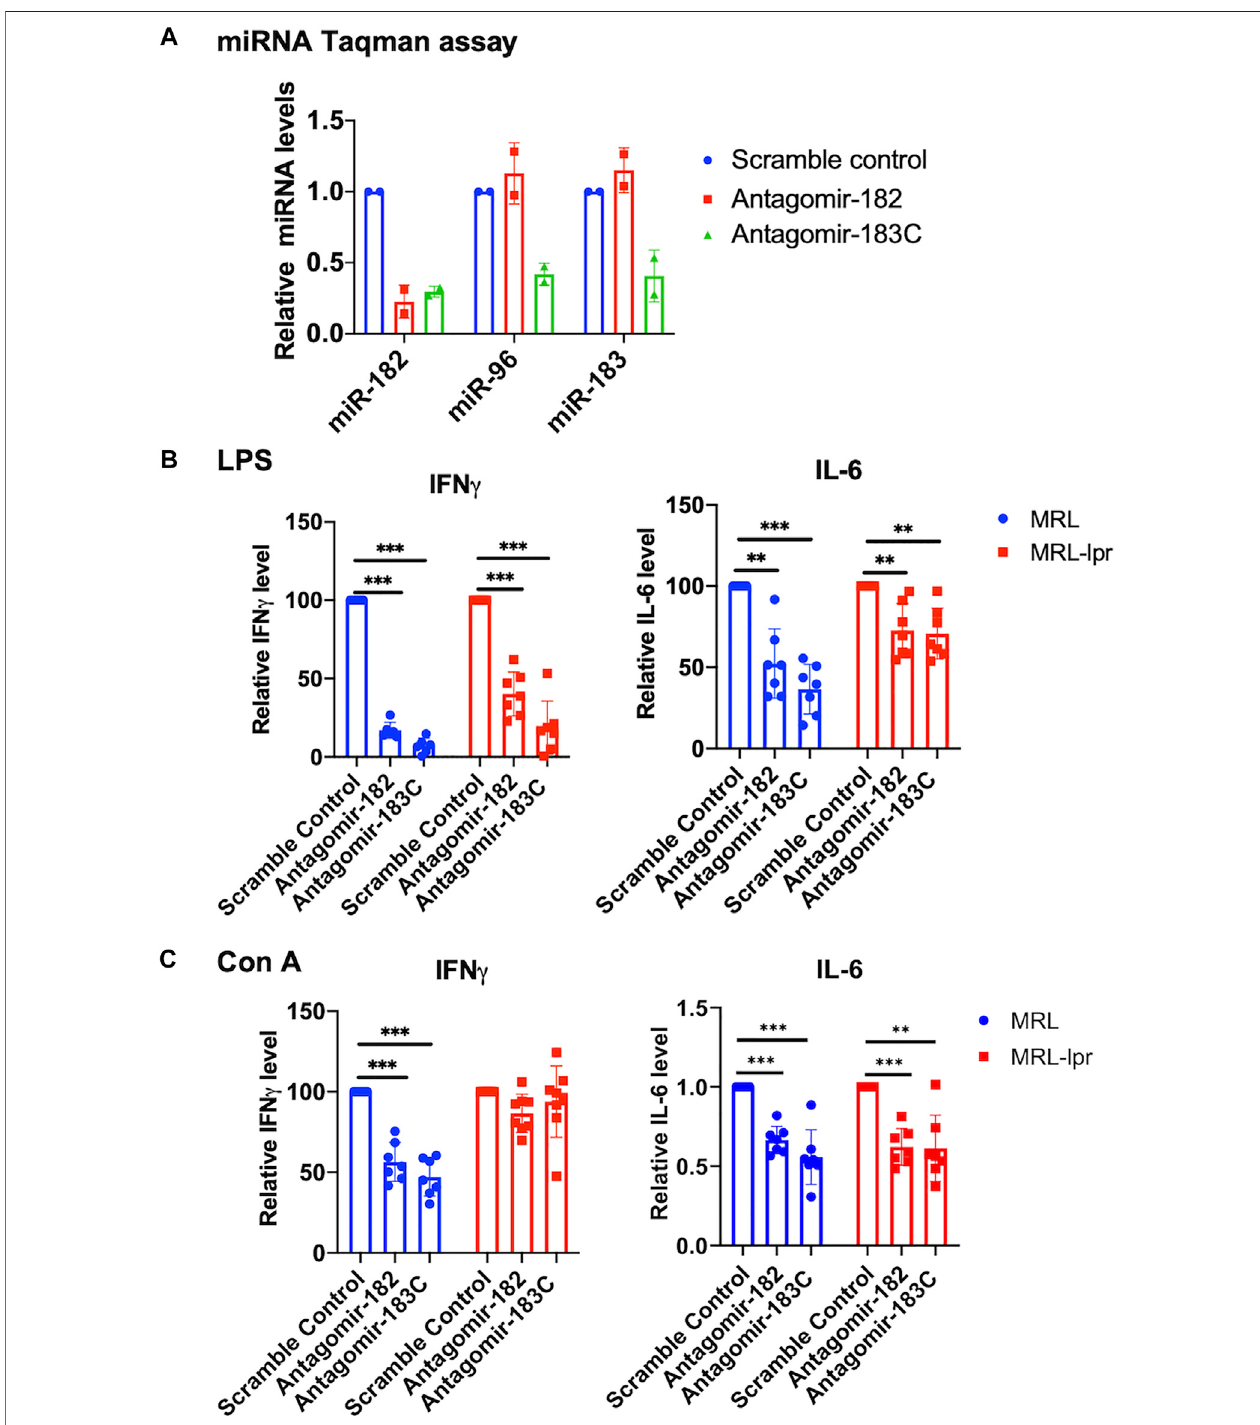
FIGURE 1 | In vitro inhibition of miR-182 alone and miR-183C miRNAs in splenocytes reduces in fl ammatory cytokines IFN γ and IL-6 expression level. (A) Antagomir-182, -96, -183 inhibited the respective miRNA ef fi ciently and speci fi cally. Freshly-isolated splenocytes from MRL/lpr mice were transfected with either scramble control, antagomir-182, or the mixture of antagomir-182, -96, and -183 (antagomir-183C). Twenty-four hours after transfection, the cells were collected for TaqMan miRNA assays. The graph showed means ± SD ( n = 2 each). (B,C) Inhibition of miR-182 or miR-183C reduced IFN γ and IL-6 production in LPS or Con A-activated splenocytes. Freshly-isolated splenocytes from MRL and autoimmune-prone MRL/lpr mice at 14 – 15 weeks ofage were treated with control antagomir and speci fi c antagomir for 24 h, and then stimulated with LPS (500 ng/ml) for 48 h or Con A (5 µg/ml) for 24 h. The IFN γ and IL-6 levels in the culture supernatant were measured by ELISA. The graphs showed means ± SD ( n ≥ 6). The cytokine level in speci fi c antagomir treated samples were shown as the percentage of paired scrambled control antagomir treated cells. Paired student t tests were performed (scrambled control vs . antagomir-182 or antagomir-183C); **, p < 0.01; and ***, p <